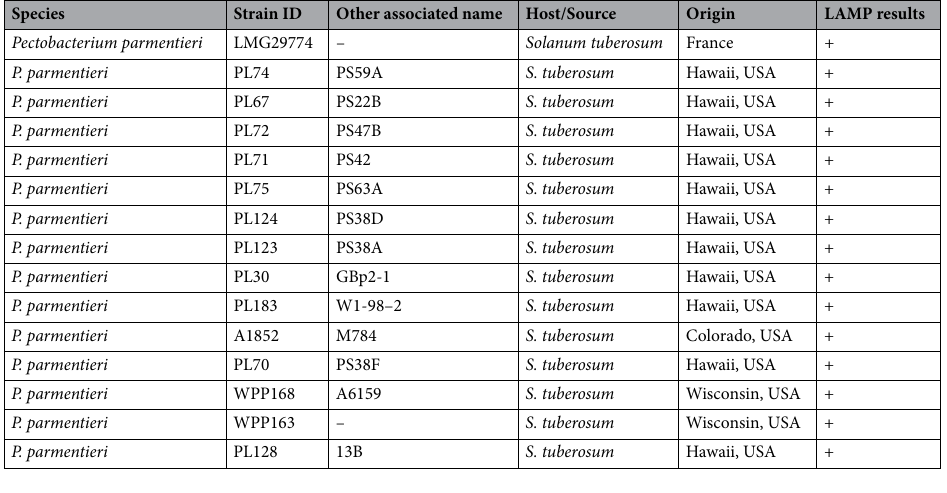
Table 2. Bacterial strains included in the inclusivity panel for validation of the loop-mediated isothermal amplification assay developed for specific and rapid detection of Pectobacterium parmentieri . Plus (+) sign indicates positive LAMP amplification; – indicates that information is not